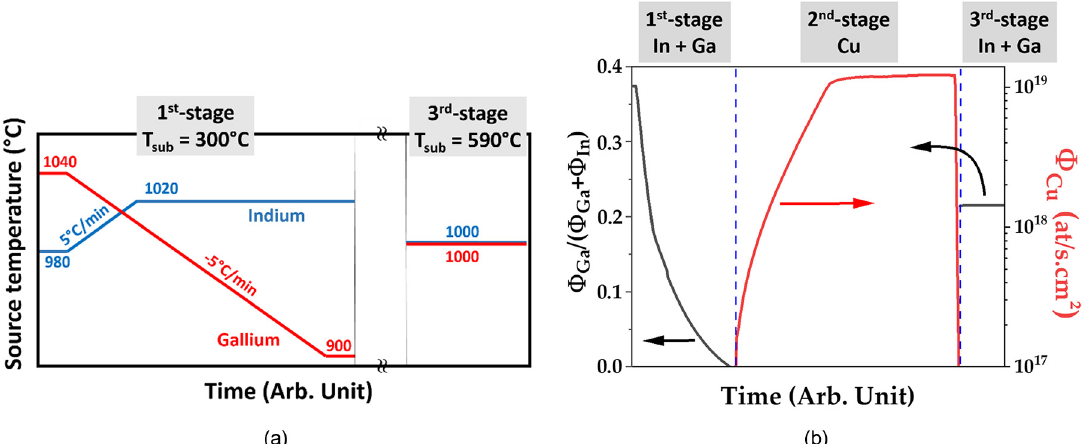
Fig. 1. (a) Variations (not to scale) of indium (in blue) and gallium (in red) source temperatures during the fi rst and the third stage of the implemented process. (b) Evolution of atom fl uxes calculated from calibration curves (i.e. rate versus source temperature). In black is represented the ratio of group III atom fl uxes during the fi rst and third stage; in red is plotted the evolution of Cu atom fl ux during the second